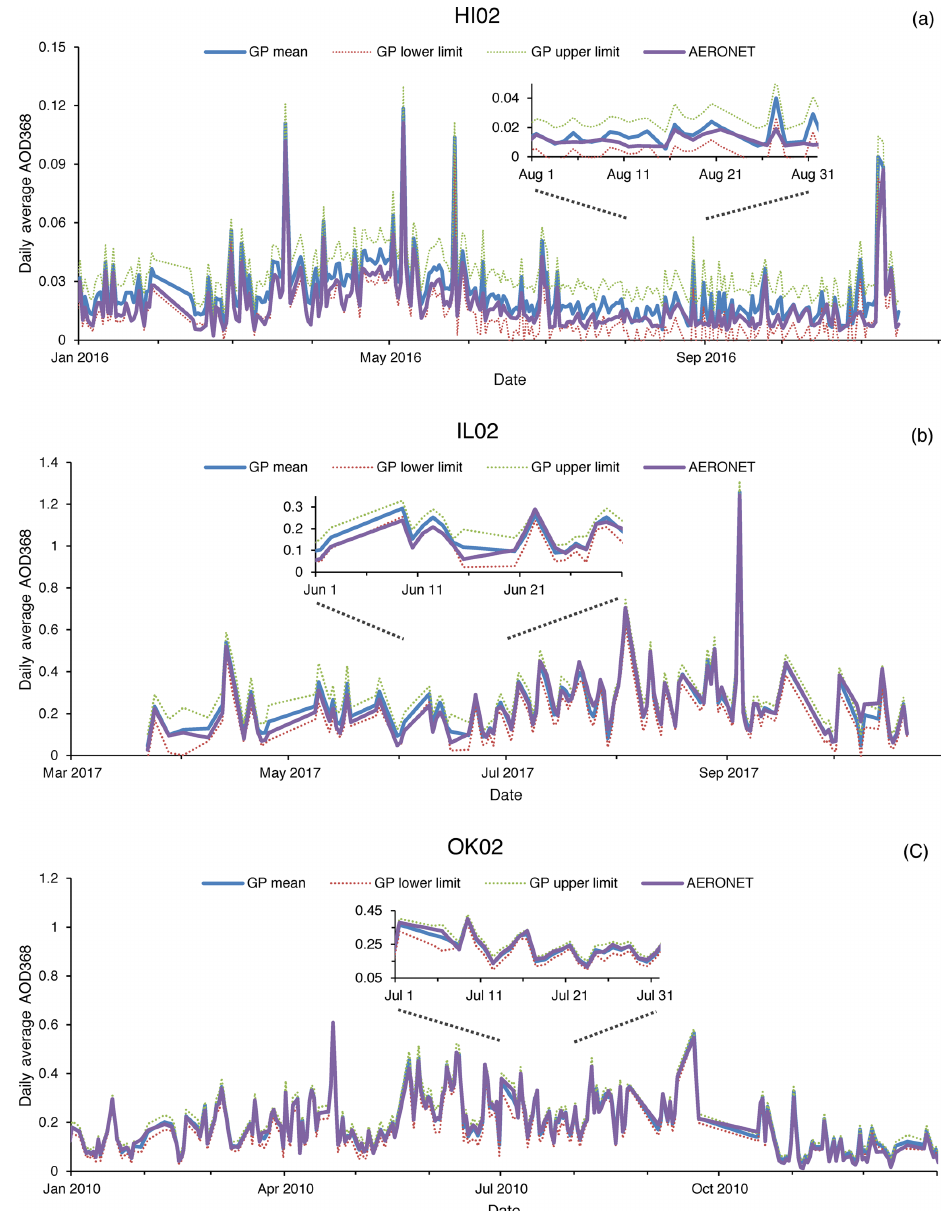
Figure 5. Time series of UVMRP and AERONET 368nm daily average AOD at the HI02, IL02, and OK02 sites. The daily AOD mean values derived from the GP mean in situ calibration factor ( V 0 ) functions (blue) and the corresponding AERONET values (purple) are shown as solid blue lines. The corresponding lower and upper limits of AOD derived from the GP V 0 confidence intervals are shown as dotted red and green lines, respectively. The insets for HI02 (August 2016), IL02 (June 2017), and OK02 (July 2010) are also included in the respective subplots to show the comparison